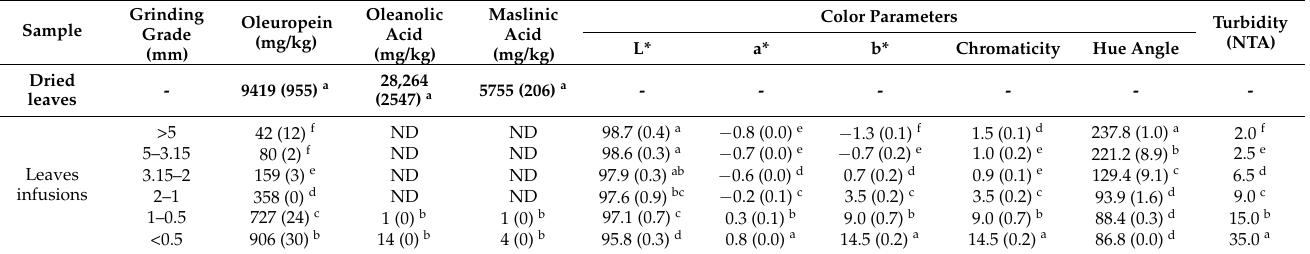
Table 2. Influence of the grinding grade on the oleuropein and triterpene content (mg/kg DW), color, and turbidity of the olive leaf infusions. Data are expressed as the mean value of triplicate. Standard deviation in parentheses. Different lowercase letters indicate significant differences according to Duncan’s multiple range test ( p < 0.05). ND: not